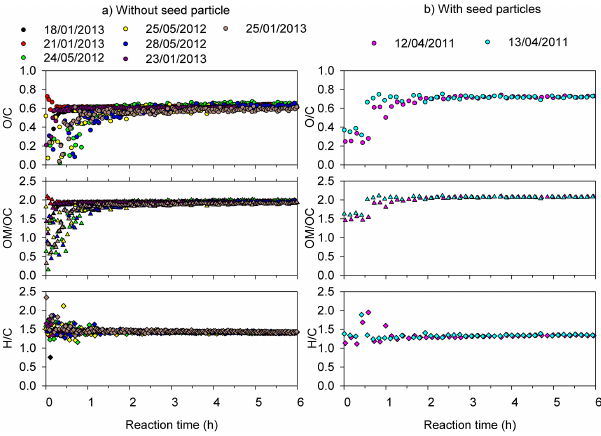
Figure 8. Time profiles of O / C, OM / OC and H / C ratios for nine different MACR photooxidation experiments performed (a) without seed particle; (b) with ammonium sulfate seed